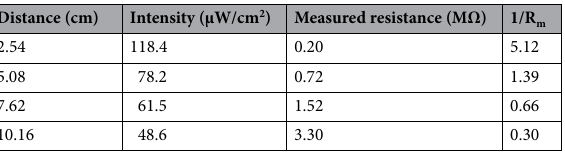
Table 3. Given intensity and measured resistance of a single LED lamp at set distances from the UV